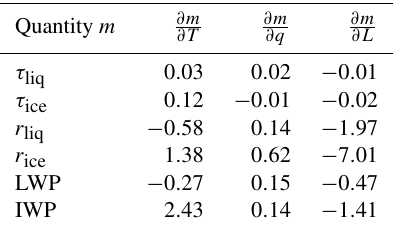
Table 4. Mean partial derivatives, used for estimating the parameter errors (cid:49)m .